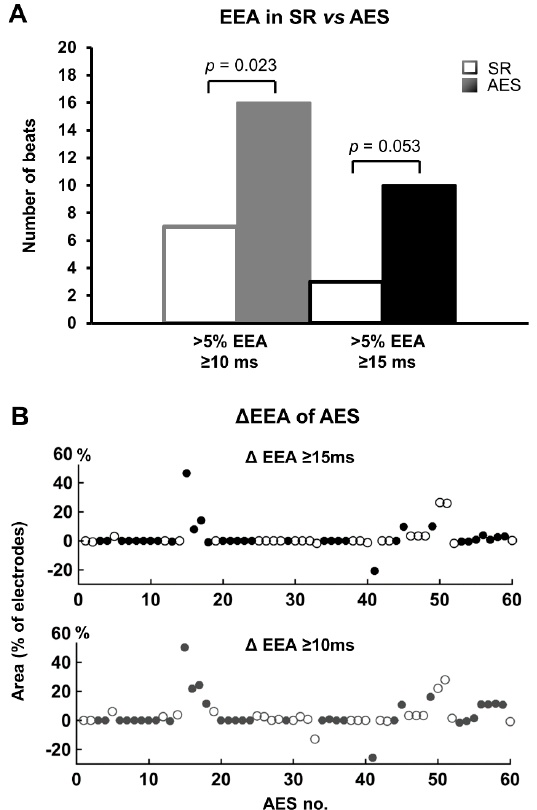
Figure 3. Change in endo-epicardial asynchrony (EEA) during atrial extra systoles (AES). ( A ) frequency histograms of EEA between 10–15 ms and ≥ 15 ms during sinus rhythm (SR) and AES. Areas of EEA covering >5% of electrodes increase during AES. For EEA ≥ 10 ms, binary logistic analysis using Generalized Estimated Equations demonstrated a significant association between >5% EEA and AES ( p = 0.023). ( B ) difference in EEA of AES compared to SR for EEA ≥ 10 ms and EEA ≥ 15 ms. Positive values represent an increase of EEA in AES, negative values represent a decrease of EEA in AES. Multiple AES in one patient are clustered and a change from an open (white) to a filled (dark) marker represents a di ff erent